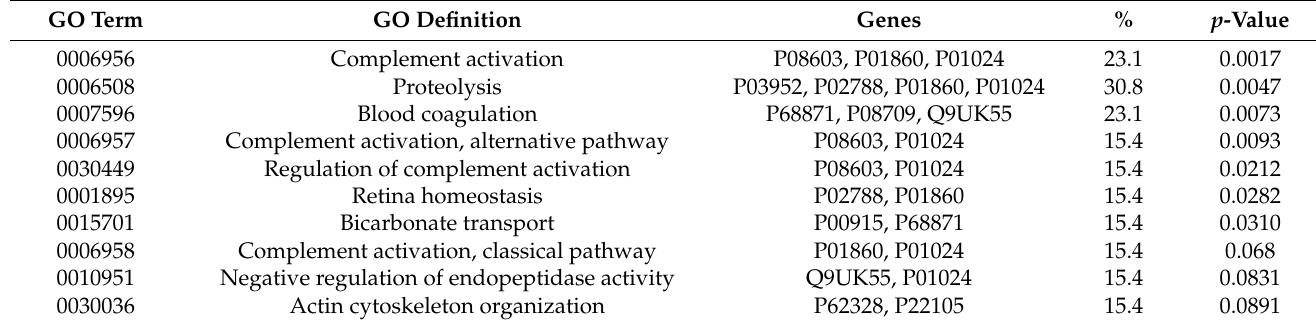
Table 3. Gene Ontology analysis of de-regulated proteins with statistically significant differences between AS vs.